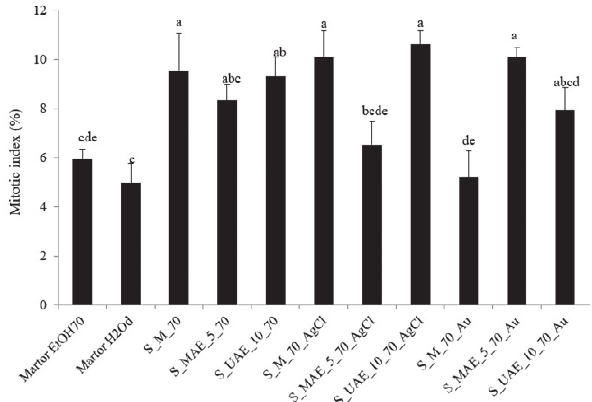
Figure 12. MI (%) of simple extracts of S. officinalis and nanostruc- tured phytochemical complexes (a–d: interpretation of the signifi- cance of the differences, by means of the Duncan test, p < 0,05).